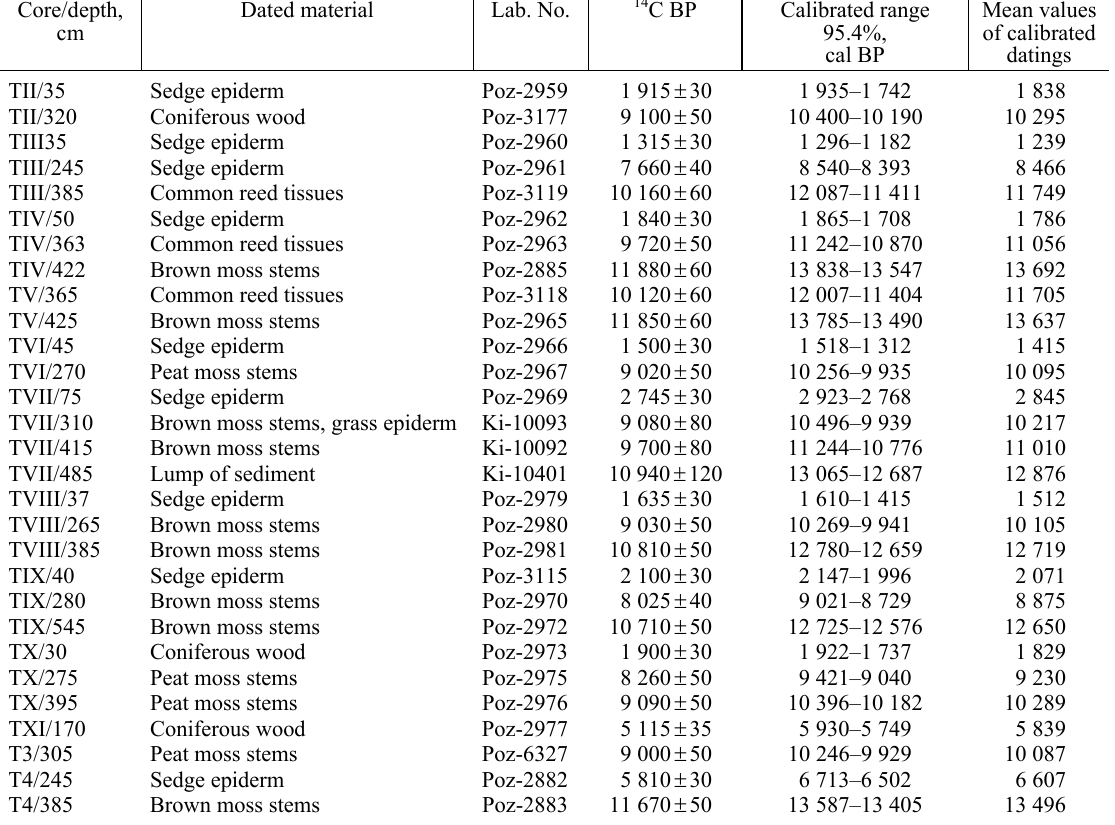
Table 1. Radiocarbon datings from the studied profiles. The radiocarbon age of the samples was calibrated with OxCal 4.2.3